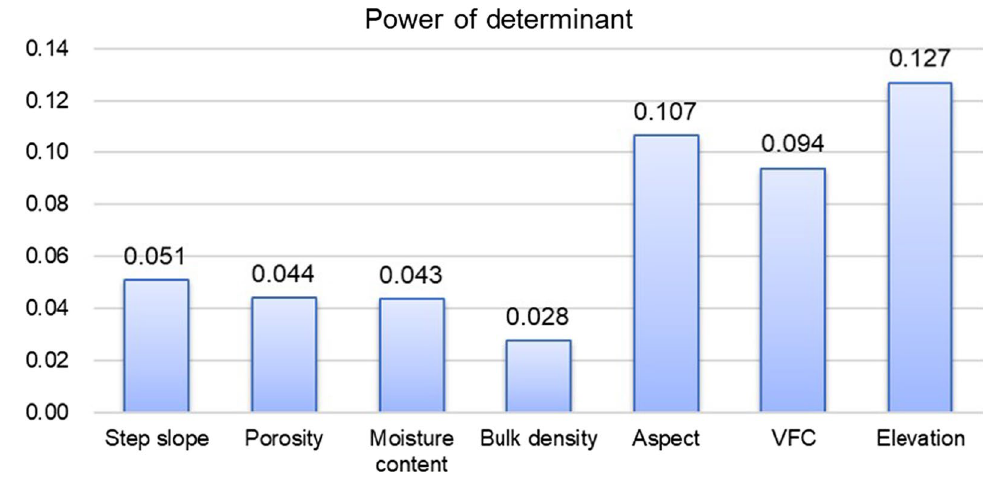
Fig. 11 Influences of different driving factors on the degree of erosion